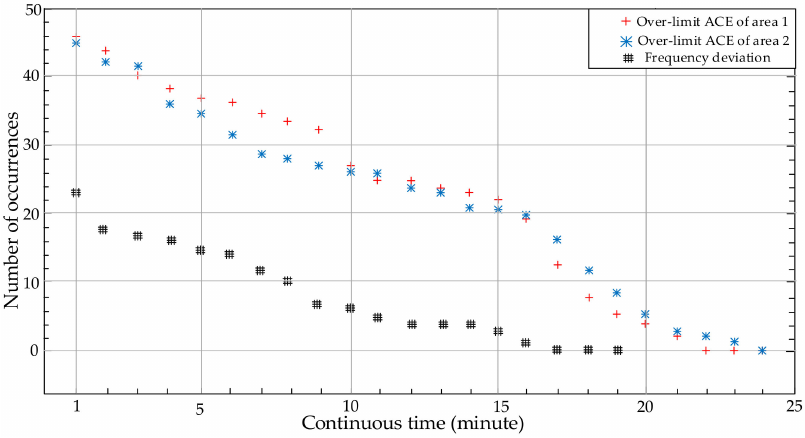
Figure 9. Occurrences of over-limit frequency and over-limit ACE for different continuous